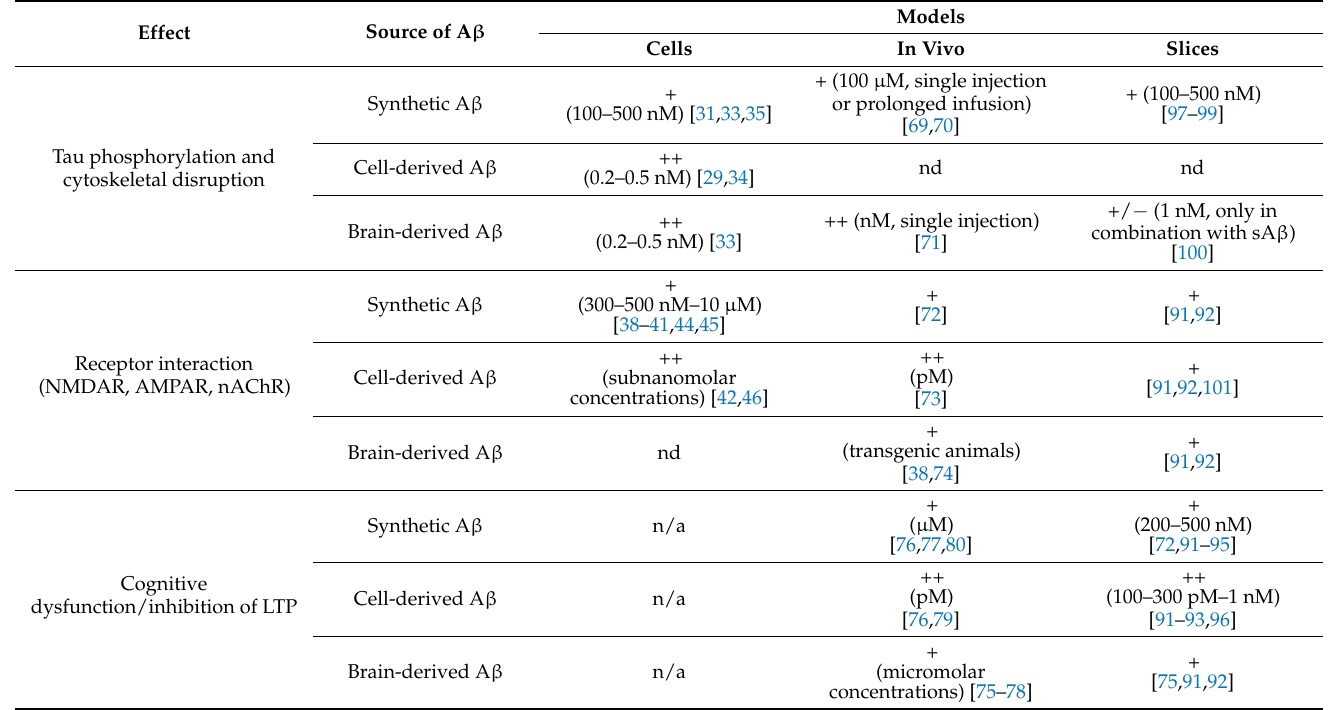
Table 1. Biological effects of synthetic, cell-derived, and brain-derived A β in different